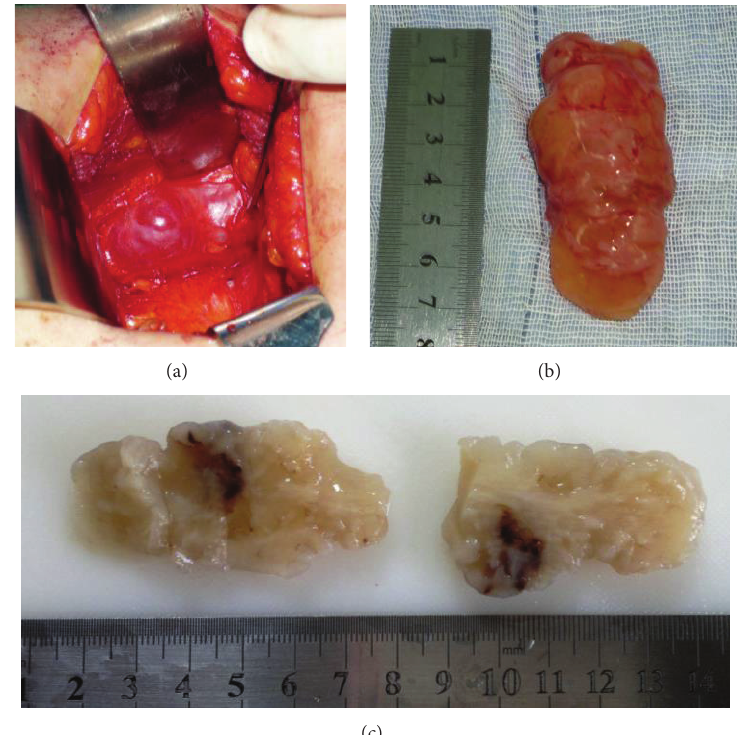
Figure 4: The right retroperitoneal mass (a), measured 7 × 3 × 3 cm, was removed (b). Hemorrhagic, cystic, and myxoid changes are seen through a cut section from the mass